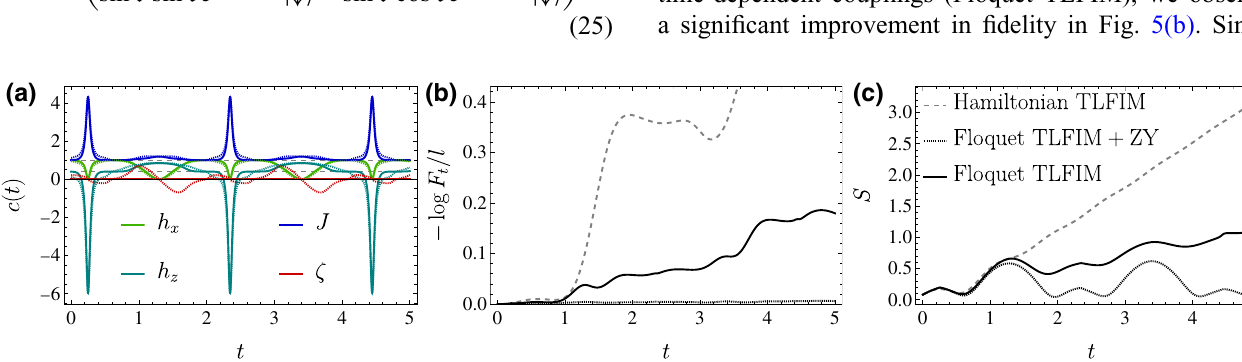
FIG. 5. (a) The time dependence of the optimal values of the parameters for the TLFIM (full lines) and the perturbed TLFIM (dotted lines). The dashed lines show the values of the parameters in the time-independent case used to generated the trajectory. (b) The logarithm of fidelity density obtained from infinite TEBD simulations [49], where F t = |(cid:4) ψ( t ) | ψ Q ( t ) (cid:2)| 2 measures how close exact unitary evolution | ψ Q ( t ) (cid:2) is to the desired MPS | ψ( t ) (cid:2) . We observe a significant improvement of fidelity for Floquet TLFIM, and nearly perfect fidelity for TLFIM supplemented by additional terms (denoted as TLFIM+ZY). (c) In line with the behavior of fidelity, the bipartite entanglement grows much slower for Floquet TLFIM, and its growth is hardly noticeable for extended Floquet driving. All data shown are computed with χ = 64 and δ t = 10 − 5